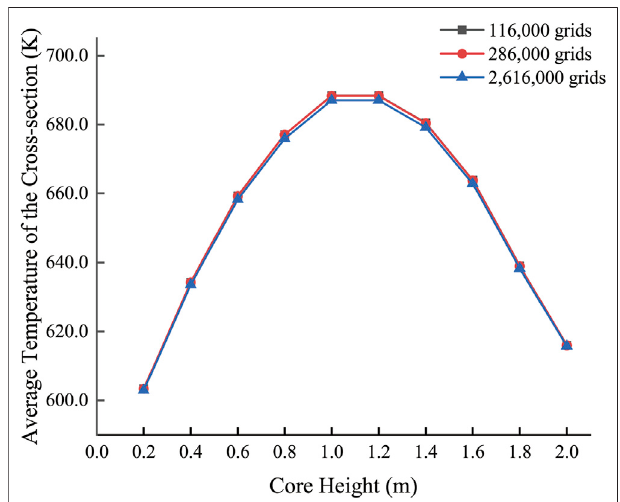
FIGURE 5 | Axial temperature distribution of the single-channel model with different numbers of